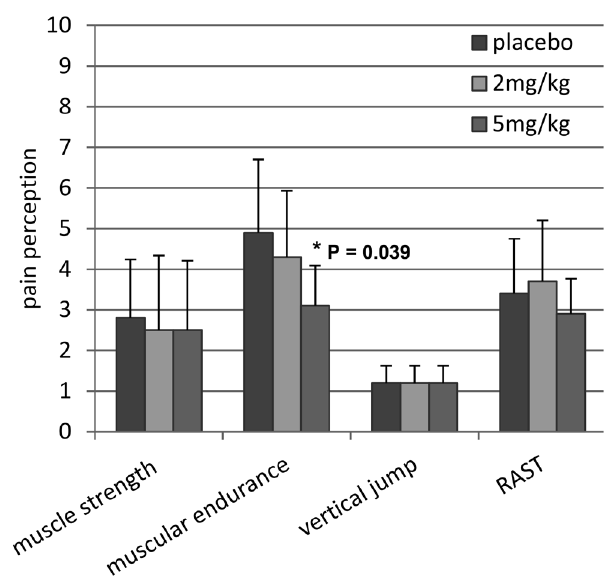
FIGURE 3 - Mean ± SD of pain perception after the tests. * Significant differences (P<0.05) compared to placebo. RAST: Running-based Anaerobic Sprint Test.